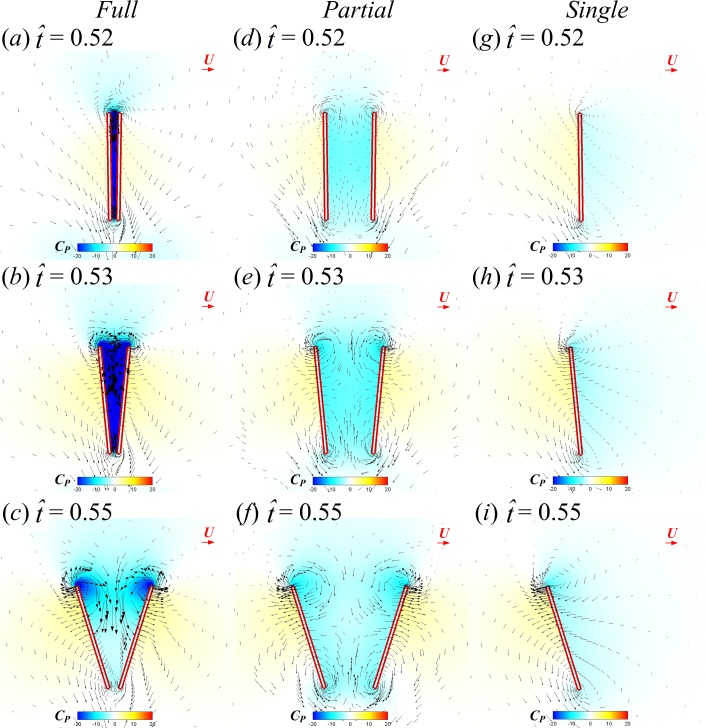
Velocity vectors and pressure distributions of the FCF case (A–C), PCF case (D–F) and SW case (G–I) in vertical plane at half-wing length for \documentclass[12pt]{minimal}
\usepackage{amsmath}
\usepackage{wasysym}
\usepackage{amsfonts}
\usepackage{amssymb}
\usepackage{amsbsy}
\usepackage{upgreek}
\usepackage{mathrsfs}
\setlength{\oddsidemargin}{-69pt}
\begin{document}
}{}$\hat {t}=0.52$\end{document}t ˆ=0.52, 0.53 and 0.55 (red horizontal arrow indicates reference velocity).